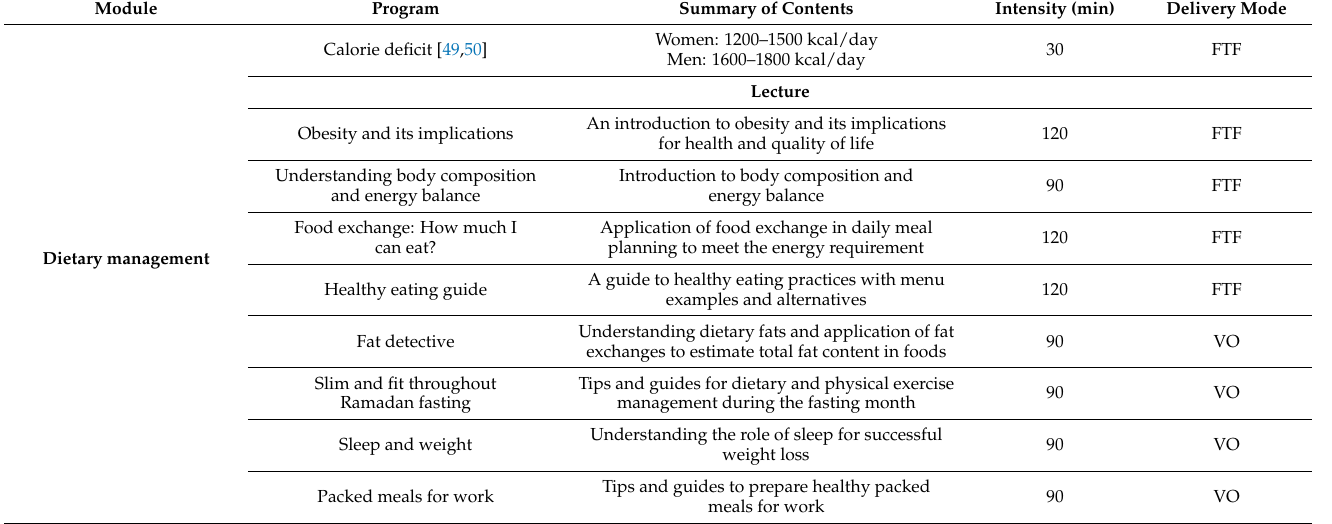
Table 2. Summary of Mind-SLIMSHAPE TM module